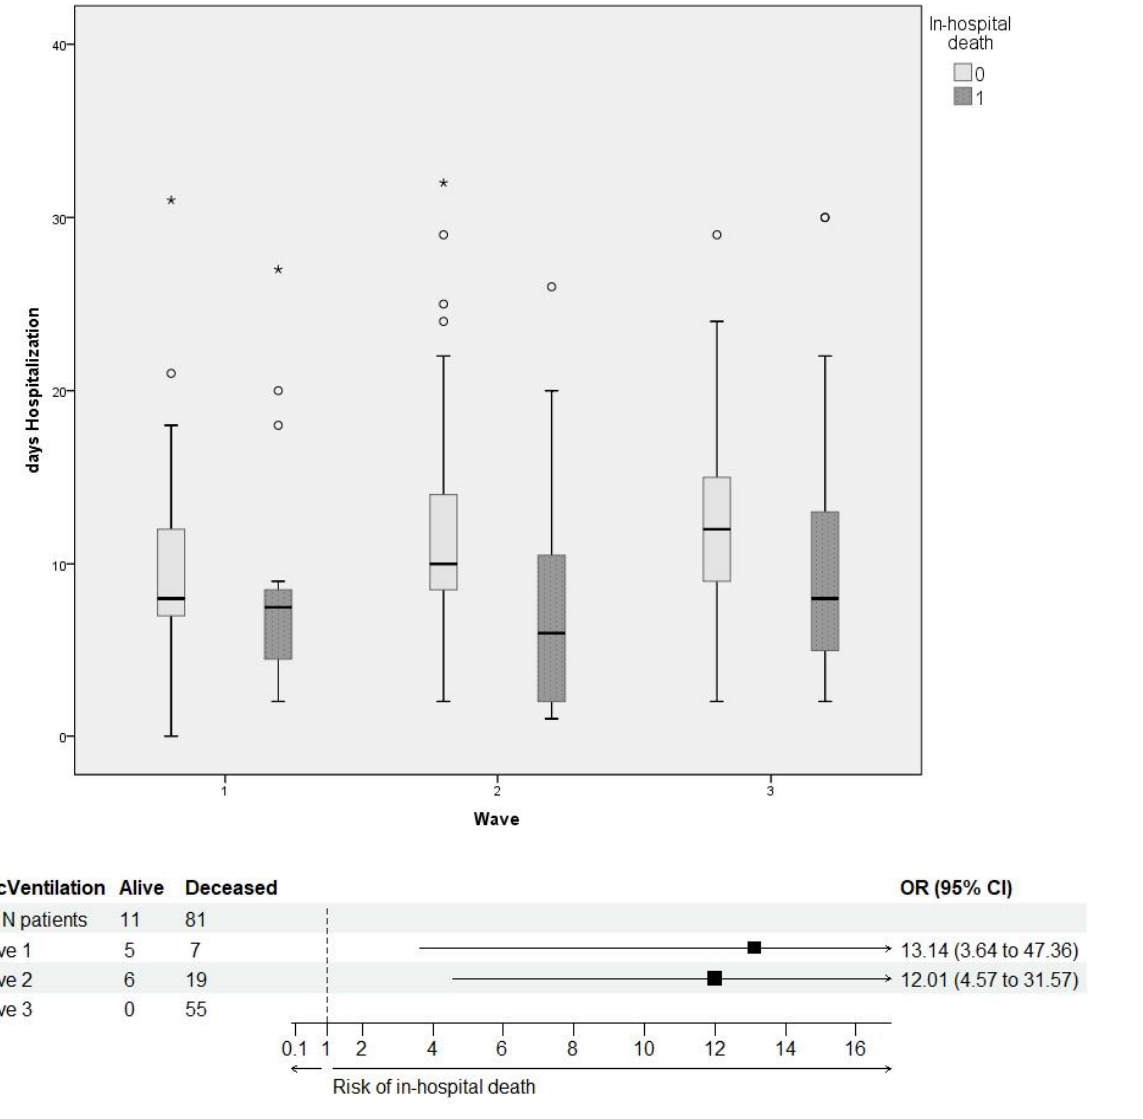
Figure 2. Relationship between the primary and secondary outcomes: ( a ) box-plots for length of hospitalization over the three waves for each possible primary outcome; ( b ) odds ratio (OR) values for in-hospital death when patients underwent mechanical ventilation. In wave 3, all 55 cases who required mechanical ventilation had unfavorable outcomes; therefore, an OR value could not be calculated.